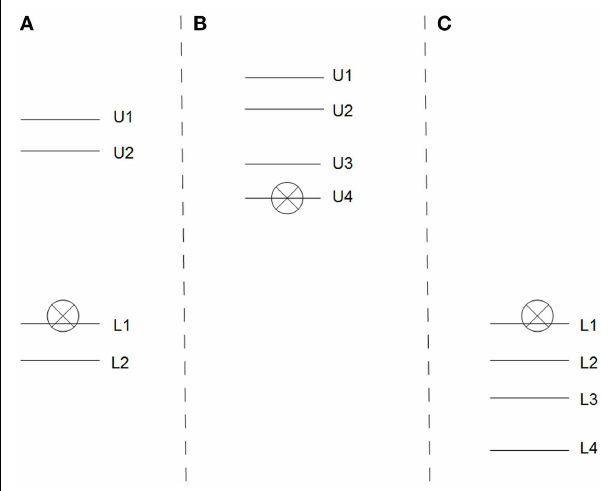
FIGURE 1 | Indirect assessment: three scenarios .The subscripts indicate the estimates made by the individual panel members. U indicates that the panel member agreed that their individual estimated value was sufficient, i.e., it represents an upper bound. L indicates that it was not.The crossed symbol represents the panel’s consensus estimate.That is, the consensus value is in situation (A,C) 0.1 above the highest of the lower estimates in situation (B) at the lowest of the upper